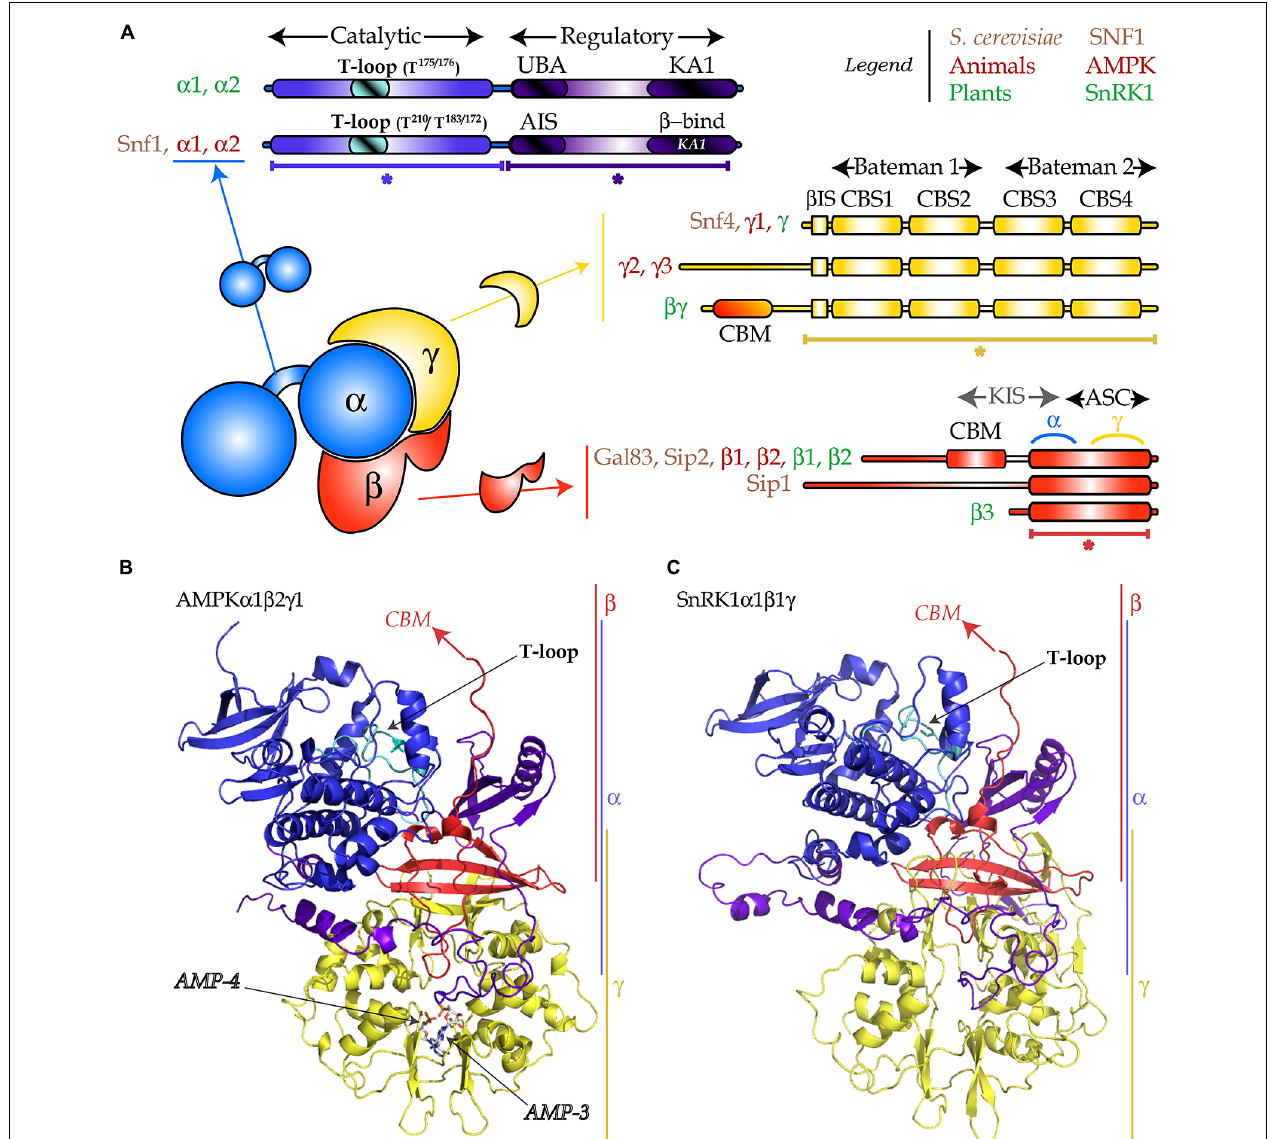
FIGURE 1 | Heterotrimeric structure of the SNF1/AMPK/SnRK1 complexes. (A) The α -subunit (in blue) is composed of a catalytic domain (in blue with the T-loop in cyan) and a regulatory domain (in purple-blue) which encompasses an auto-inhibitory sequence (AIS) or an ubiquitin-associated (UBA) domain, and a kinase-associated (KA1) domain for binding the β - and γ -subunits. The γ -subunit (in yellow) is composed of two “Bateman” domains each of them containing two CBS (cystathionine- β -synthase) domains and a β -interacting sequence ( β IS). The AMPK γ 2 and γ 3 bear an N-terminal extension and the plant-specific SnRK1 βγ possesses a carbohydrate binding module (CBM). The β -subunit (in red) harbors an ASC (association to the complex) domain, containing the